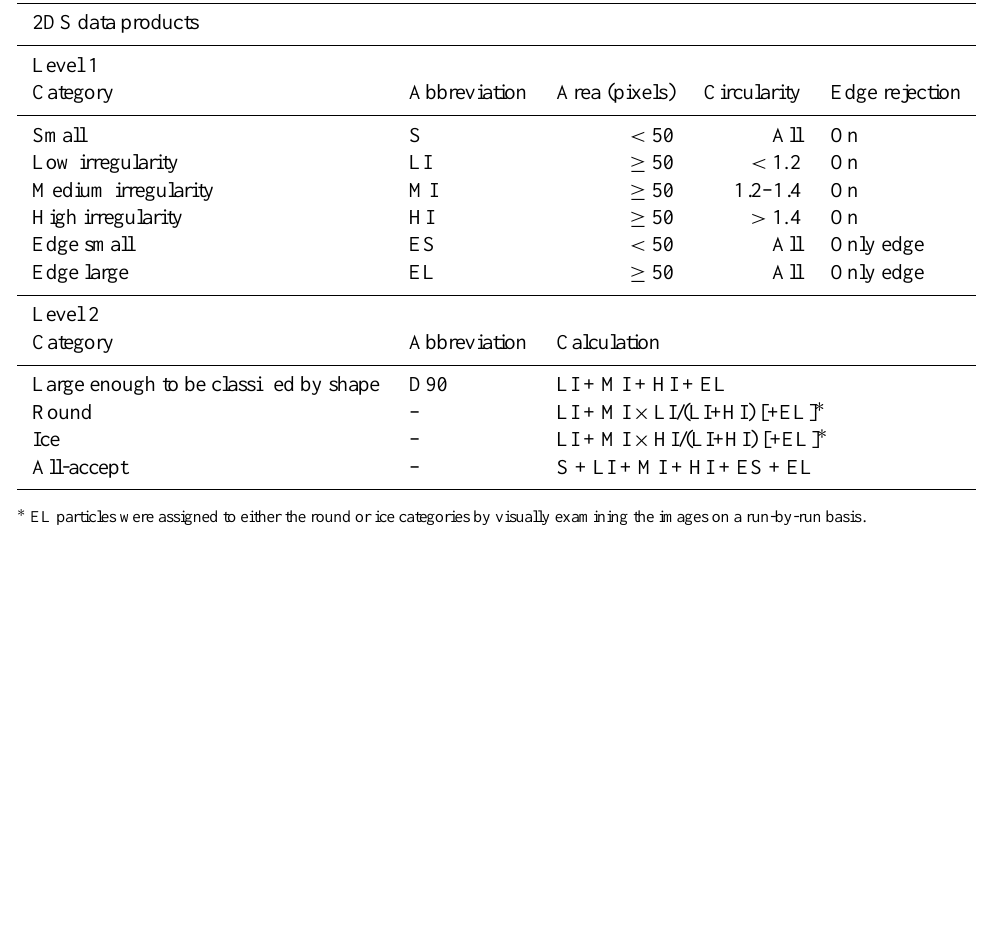
Table A1. Summary of 2DS data products. Level 1 refers to standard products output by the data processing software, and are mutually exclusive (i.e. any accepted particle falls into only one level 1 category). Level 2 products are specific to COPE. Particles with IAT < 1µs were excluded in all categories to minimise shattering